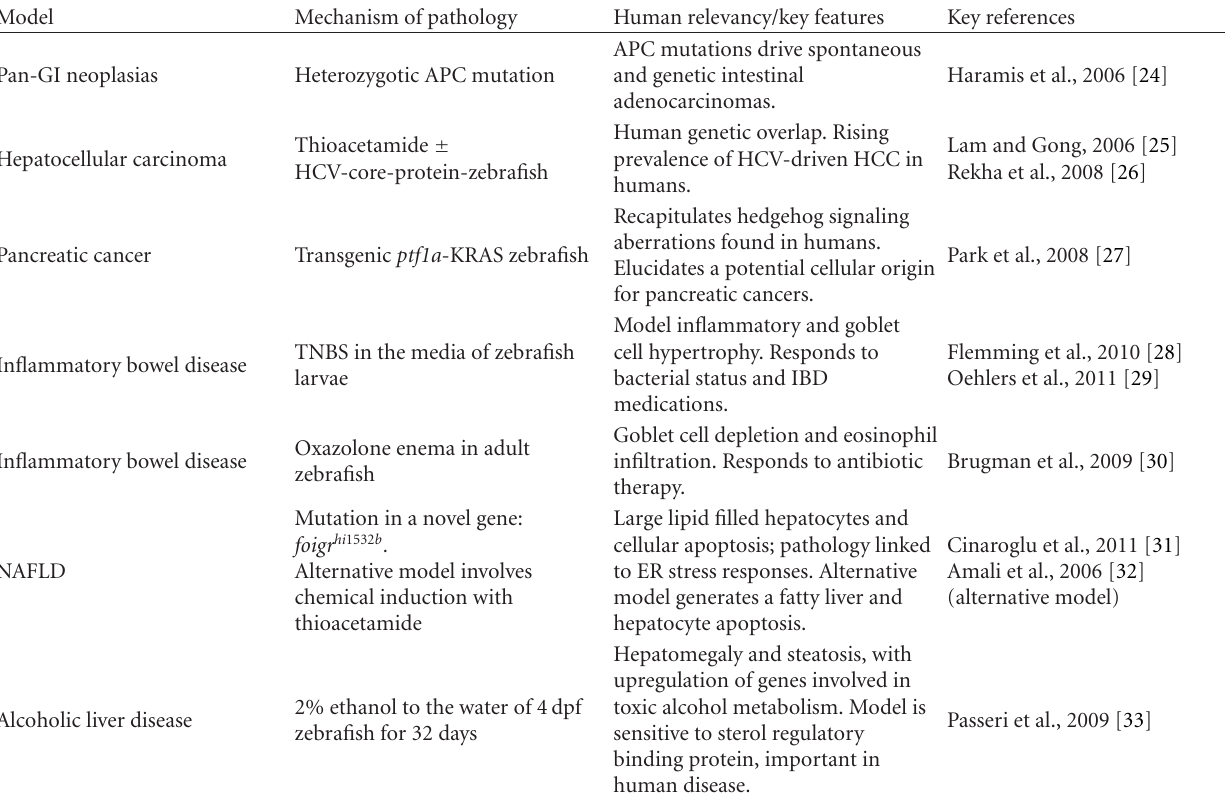
Table 1: Zebrafish gastrointestinal models of